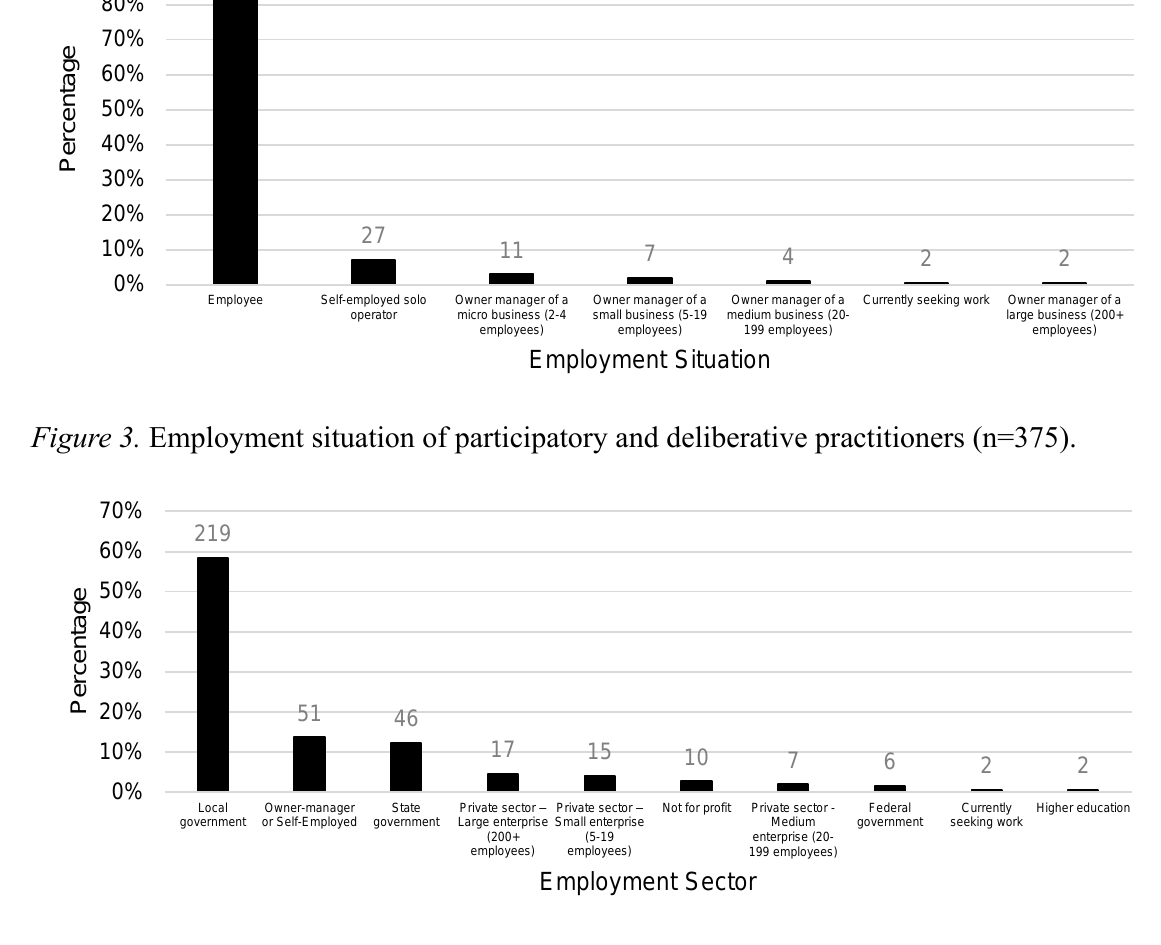
Figure 4. Employer of participatory and deliberative practitioners